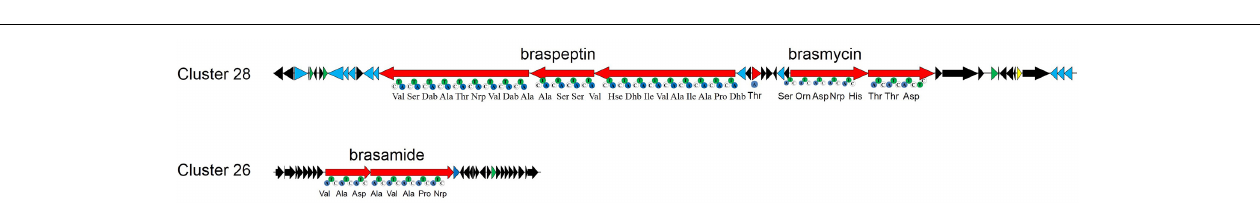
FIGURE 1 | In silico analysis and comparison of secondary metabolite production in Pseudomonas sp. 11K1 and strains of related species. Clusters accounting for biosynthesis of secondary metabolites were predicted by antiSMASH 4.0 using the “Extra Features” settings. Numbers represent the number of gene clusters within a genome. Abbreviations are as follows: CLPs, cyclic lipopeptides; DAPG, 2,4-diacetylphloroglucinol; PRN, pyrrolnitrin; PLT, pyoluteorin; NRPS, non-ribosomal peptide synthase. Pseudomonas strains were divided into groups I (gray), II (blue), and III (orange) based on profiles of secondary metabolites. Group I species produce all four antimicrobial compounds DAPG, PLT, PRN, and CLPs; Pseudomonas strains of Group II produce DAPG but not PLT, PRN, or CLPs; Pseudomonas strains of group III, including strain 11K1, produce CLPs but not DAPG, PLT, or PRN. The phylogenetic tree of 16S rDNA sequences (left) was constructed using the neighbor-joining method in MEGA version 5.0 after multiple sequence alignment by ClustalW.